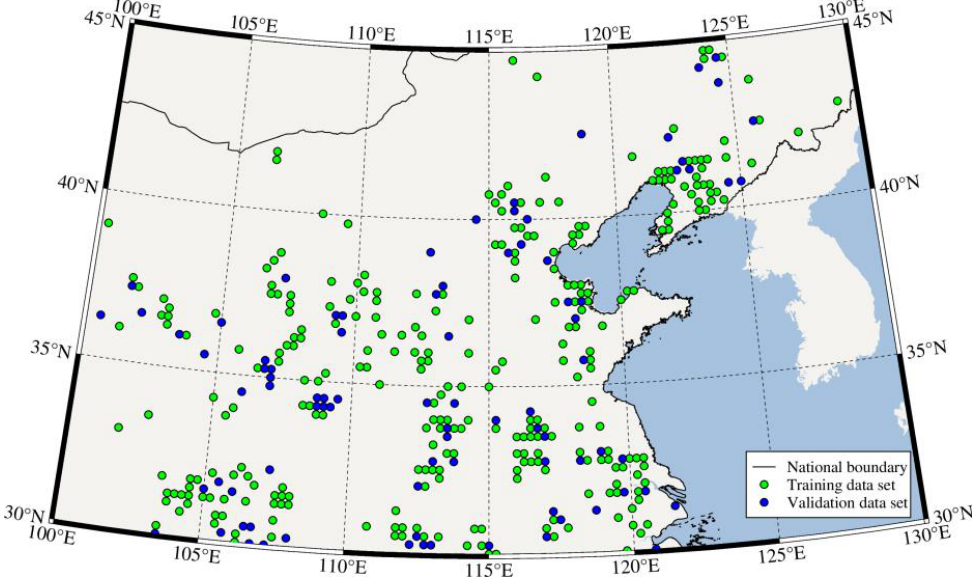
Figure 4. Distribution of the training and the validation data points. In order to assess the accuracy of the heat flow prediction, the uncertainty of the prediction results was quantified by using mean absolute error ( MAE ), and normalized mean square error ( N_RMSE ). MAE represents the average of the absolute values of the deviation of all individual observations from the arithmetic mean, with smaller values representing a smaller deviation of the data values from the mean; N_RMSE is a simplified transformation of the expression of mean square error. The value is between 0 and 1, with smaller values representing smaller errors. The calculations of MAE and N_RMSE are shown in Equations (11) and (12) [26],